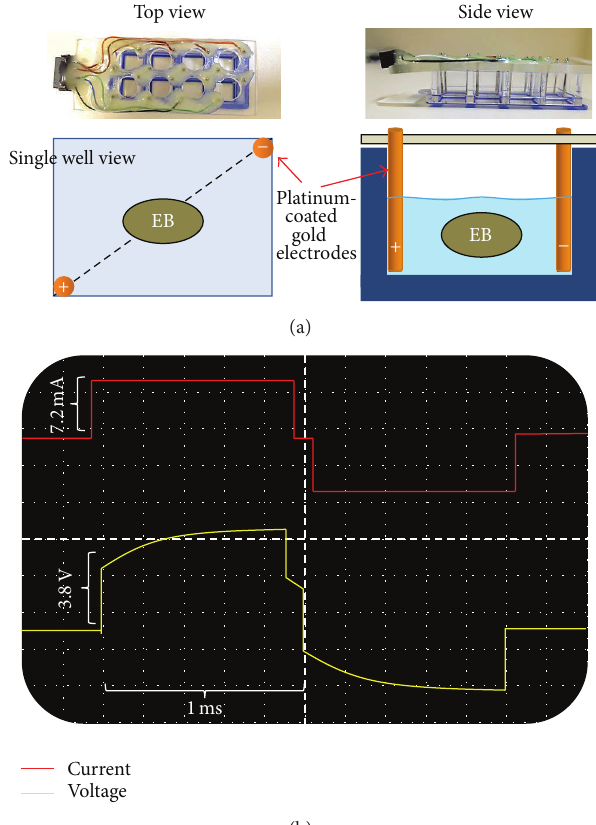
Figure 2: Custom made electrical stimulator. (a) A panel of 16 platinum-coated gold electrodes that fit into an 8-well chamber slide. Each well contained a pair of electrodes to stimulate the EBs in suspension. (b) Representative oscilloscope diagram of a pair of electrodes (at 200 mV/mm of the electric field) showing a charge-balanced biphasic current pulse (red) and the corresponding electrode voltage (yellow). Each current pulse was 1 ms/phase and was stimulated at 1 Hz. EB: embryoid